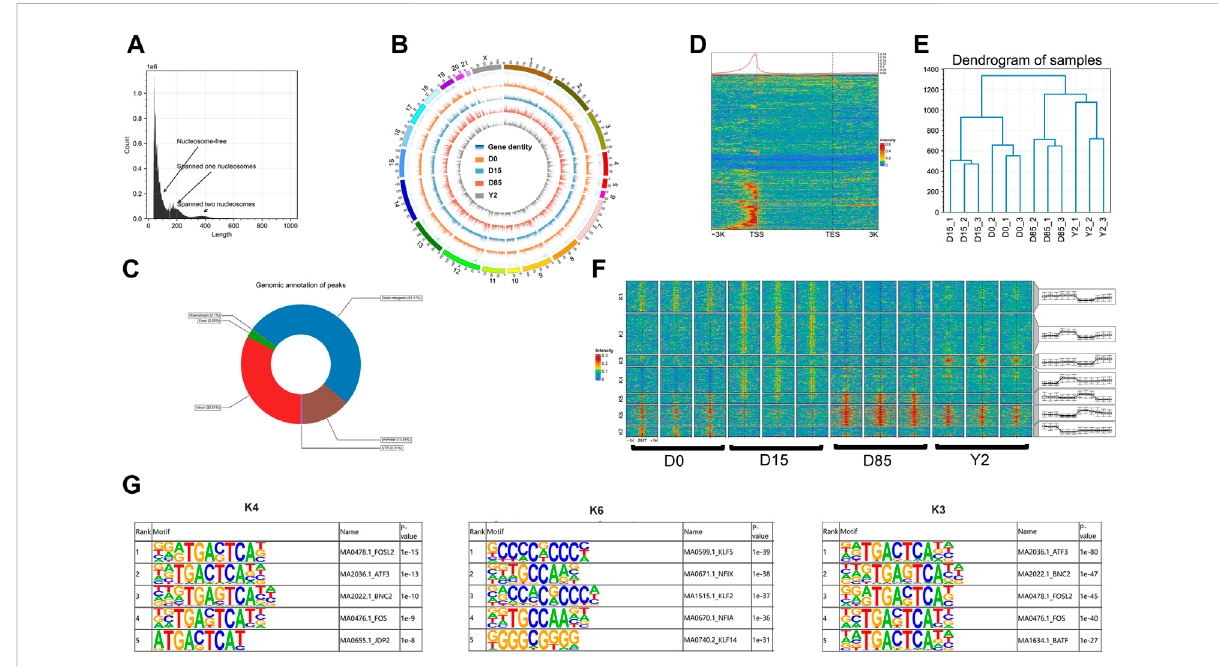
FIGURE 2 The landscape and dynamics of chromatin accessibility during rabbit BAT whitening. (A) Fragment lengths detected in a representative ATAC- seqlibrary. (B) Genome-widechromatinaccessibilityofsamplesinD0,D15,D85,andY2. (C) Genomicannotationofpeaks. (D) EnrichmentofATAC- seq reads around the gene bodies of a representative sample. The red and blue colors show the higher and lower ATAC-seq signals, respectively. (E) Hierarchical clustering analysis based on the signal intensity of genome-wide chromatin accessible regions (peaks). The signal intensities of peakswerenormalizedusingCPM. (F) Heatmapanalysisof25,464differentialpeaks(DPs)usingK-meansmethod.Thecolorscaleshowstherelative signal intensities of peaks. SMT, the summit of peaks. The chromatin accessible patterns of DPs in different clusters of each replicate are shown in corresponding box-plots. (G) TF binding motif enrichments of peaks in cluster K4, K6, and K3. Integrated analysis of ATAC-seq and RNA-seq data revealed chromatin accessibility regulating gene